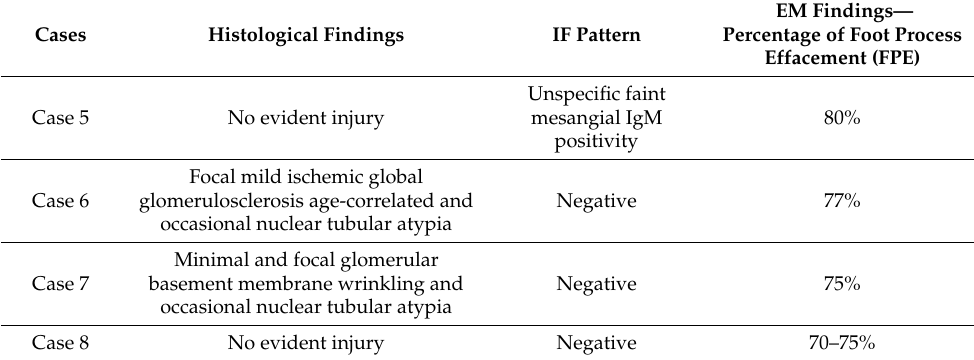
Table 3. Histomorphological and ultrastructural features of MCD.